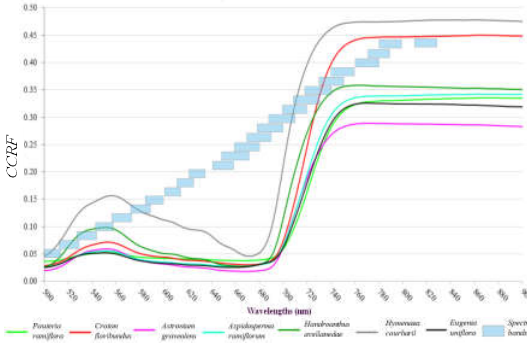
Figure 2. CCRF curves of leafs and selected spectral bands (Adapted from Miyoshi, 2016).